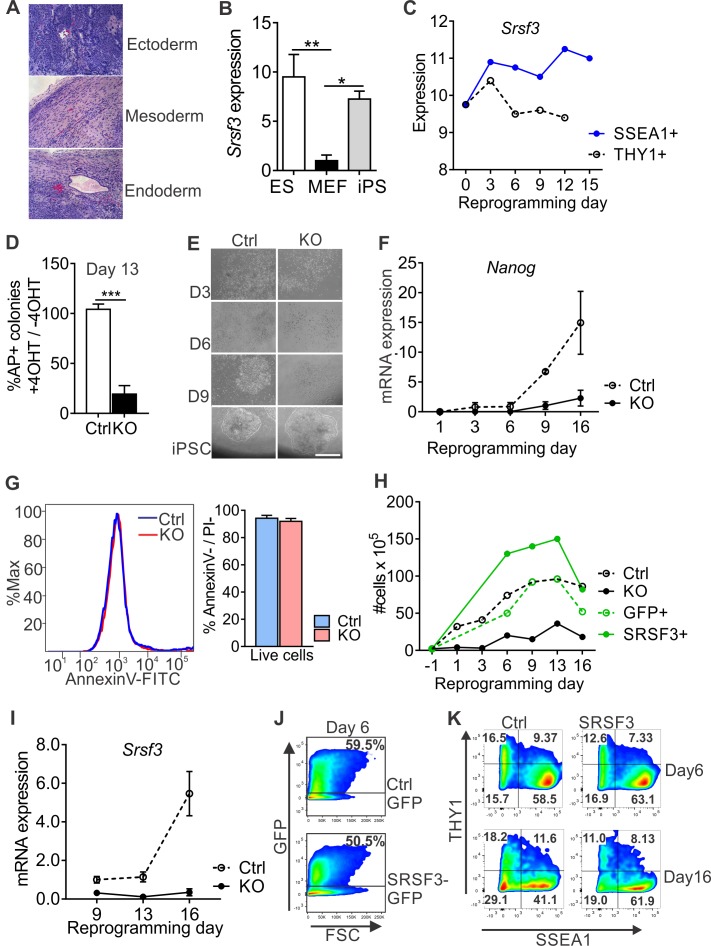
SRSF3 depletion and overexpression have the opposite effects on reprogramming outcome.(A) iPSCs cells generated from Cre-negative m3-OKSM MEFs form teratomas when injected into immunocompromised mice. (B) Quantification of Srsf3 mRNA levels by RT-qPCR in ESCs, MEFs and iPSCs. One-way ANOVA, Tukey’s multiple comparison test (*p<0.05; **p<0.01, data as mean ± SEM, n = 3). (C) Srsf3 mRNA expression increases during reprogramming in the SSEA1 +population. The graph is based on data from Polo et al. (2012). (D) Quantification of AP-positive colonies in Srsf3-KO/OKSM and control cultures at day 13 of reprogramming. The data is presented as relative number of colonies between treated (+4 OHT) and untreated (−4OHT) samples that were reprogrammed in parallel (Unpaired Student’s t-test, two-tailed, ***p<0.001, data as mean ± SEM, n = 4–5). (E) Phase contrast images of reprogramming Srsf3-KO/OKSM and control cultures at different time points. Scale bar 50 μm. (F) Quantification of Nanog mRNA expression as in Figure 1D. (G) Flow cytometric quantification of apoptotic and dead cells by AnnexinV/PI labelling 48 hr after 4OHT induction in reprogramming Srsf3-KO/OKSM and control MEFs. Histogram of a representative experiment (left) and quantification of live cells (right) are presented (Unpaired Student’s t-test, two-tailed, *p>0.05, data as mean ± SEM, n = 3). (H) Quantification of cell numbers during reprogramming in control (Ctrl), Srsf3-KO/OKSM (KO), GFP-only control (GFP+) and SRSF3-T2A-GFP overexpressing (SRSF3+) cells (data as mean). (I) Quantification of Srsf3 mRNA expression after 4OHT induction at day 8 as in (F). Data is presented relative to day 9. (J) Flow cytometric analysis of GFP and SRSF3-T2A-GFP expression on day 6 of reprogramming. (K) Analysis of SSEA1 and THY1 cell surface marker expression at days 6 and 16 of reprogramming in GFP-only (Ctrl) and SRSF3-T2A-GFP (SRSF3) overexpressing cells. Live GFP+ cells were gated and cell surface markers assessed in the transduced cell population.